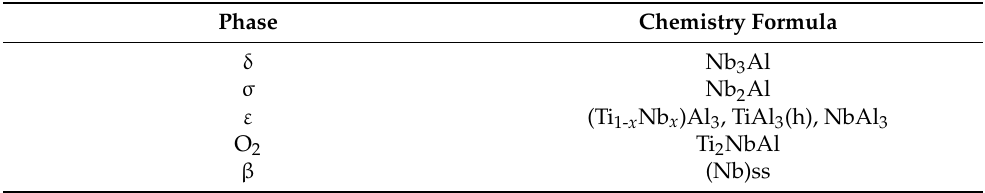
Table 2. The phases and the correlative chemical formula.